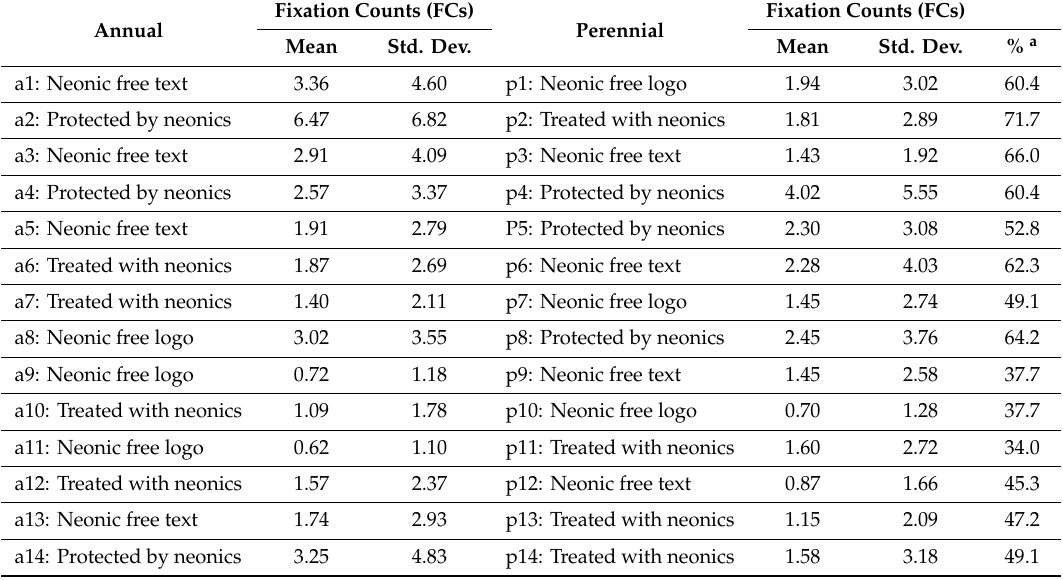
Table 4. Summary of fixation counts to neonicotinoid